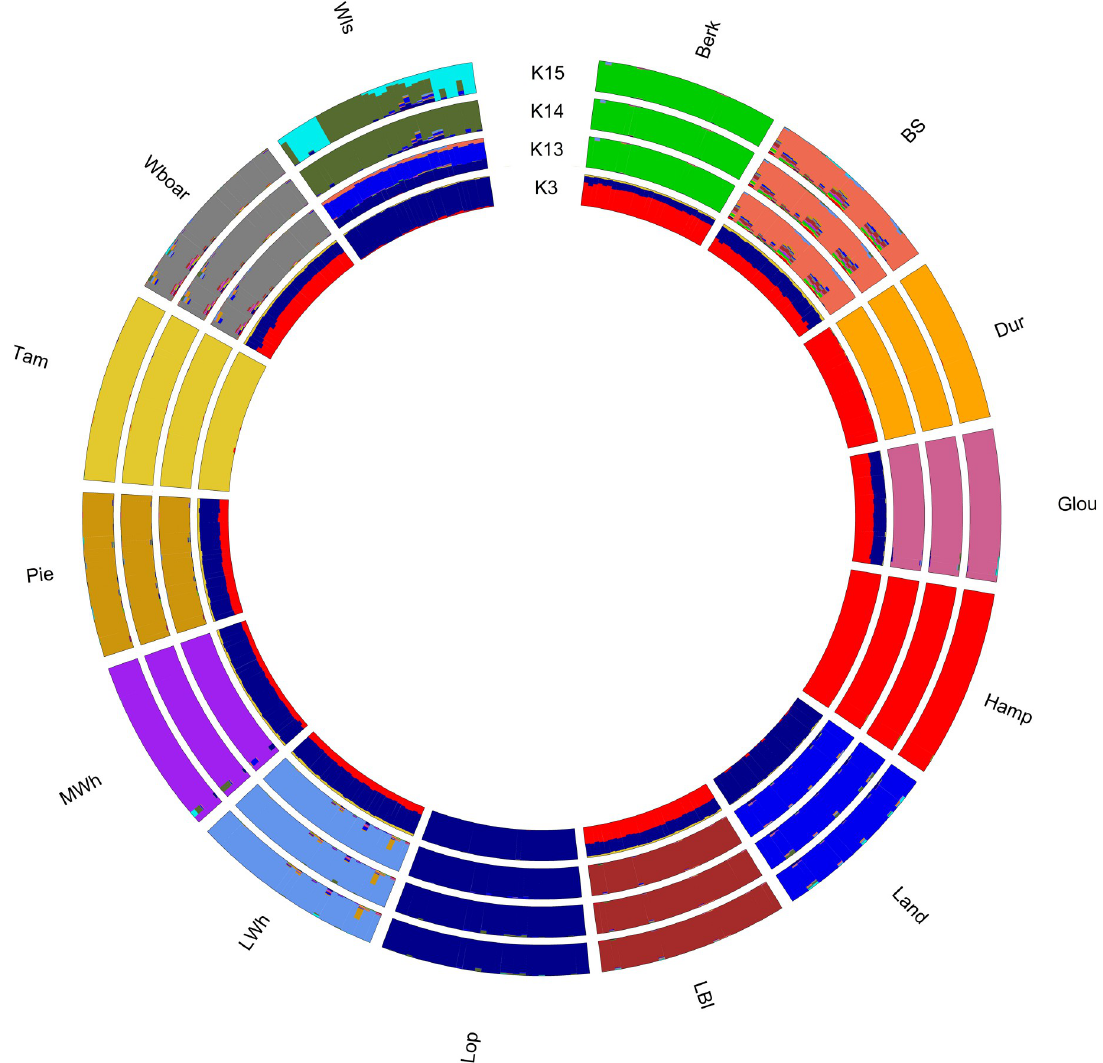
Fig 5. Unsupervised admixture analysis of the studied pig populations for 3, 13, 14 and 15 ancestral populations (K3, K13, K14, K15). For a total of 405 samples and 14,628 SNPs. Admixture levels were estimated using the ADMIXTURE software. Error estimates were calculated using a 5-fold cross-validation to estimate the most likely value for the number of ancestral populations (K). The label was given a posteriori by comparing the membership coefficient with the known breed. As such, cluster codes are: Berkshire (Berk), British Saddleback (BS), Duroc (Dur), Gloucestershire Old Spots (Glou), Hampshire (Hamp), Landrace (Land), Large Black (LBl), Large White (LWh), Lop (Lop), Middle White (MWh), Pietrain (Pie), Tamworth (Tam), Welsh (Wls) and Wild boar